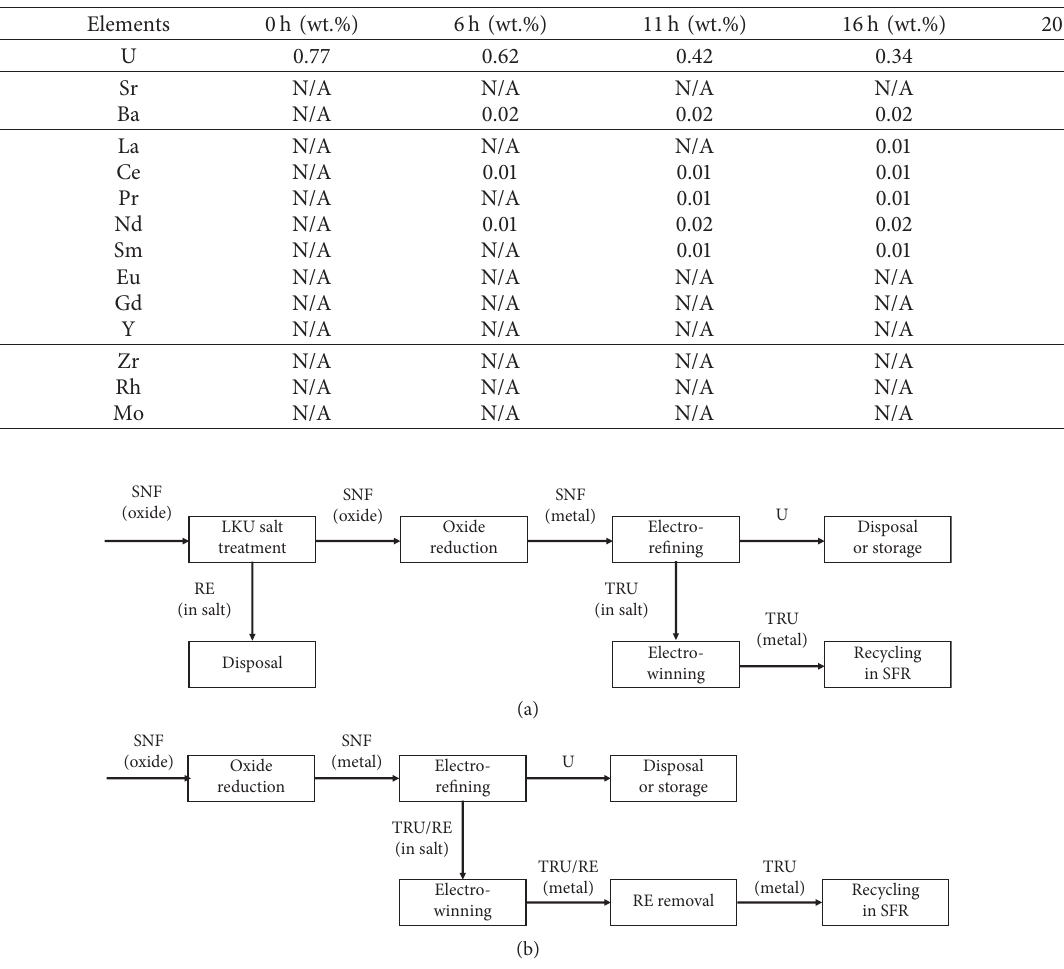
Figure 3: Flowchart of pyroprocessing (a) with and (b) without RE removal using the LKU treatment (no TRU removal assumed).